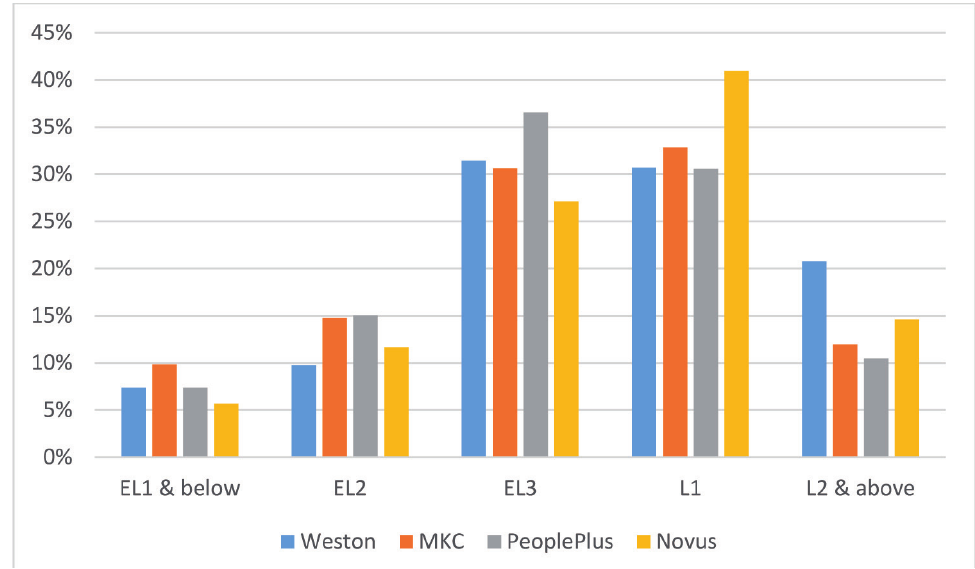
Figure 9: Prisoners’literacylevelsbyprovider